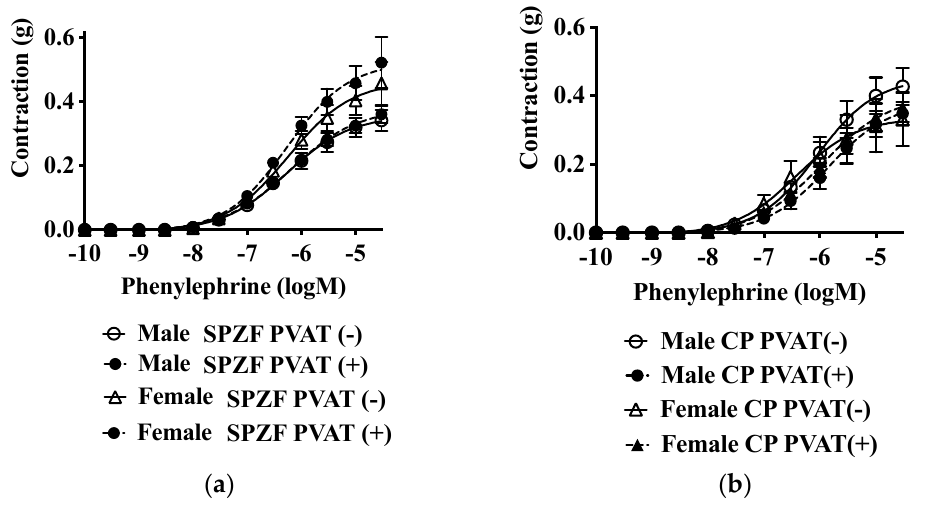
Figure 3. Vascular contractile response to phenylephrine in renal arteries with or without perivascu ‐ lar adipose tissues [PVAT (+/ − )] of male and female SHRSP.Z ‐ Lepr fa /IzmDmcr rats (SPZF, a ) and SHR/NDmcr ‐ cp rats (CP, b ) at 23 weeks of age. Data are expressed as means ±SEM. n = 9 rats/group.